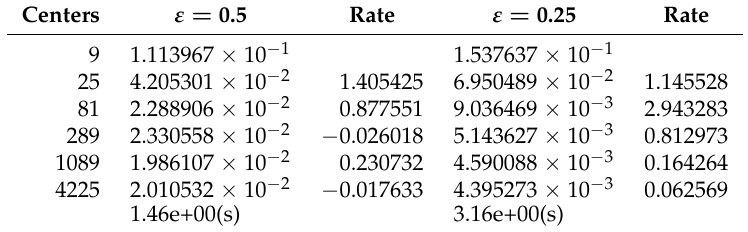
Table 2. CSRBF interpolation: stationary.